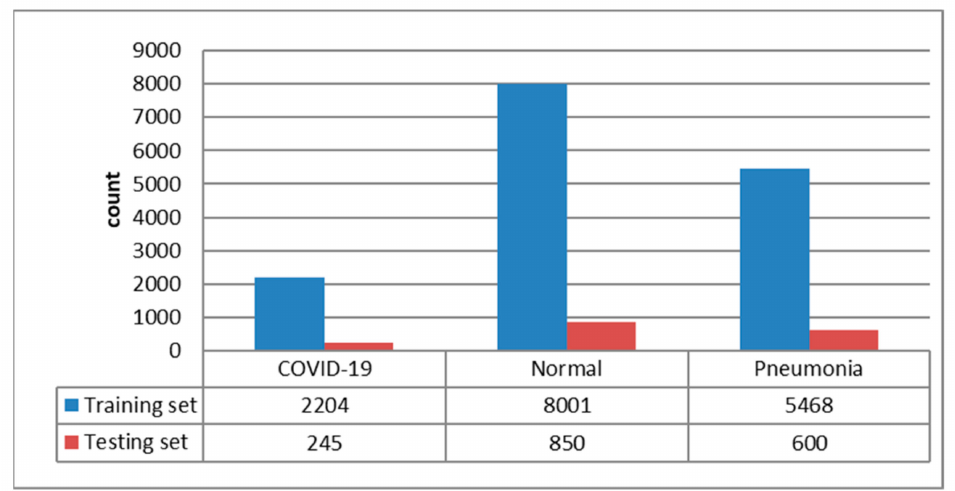
Figure 3. Sample distribution of this research. We roughly split 10% of the original data into the testing